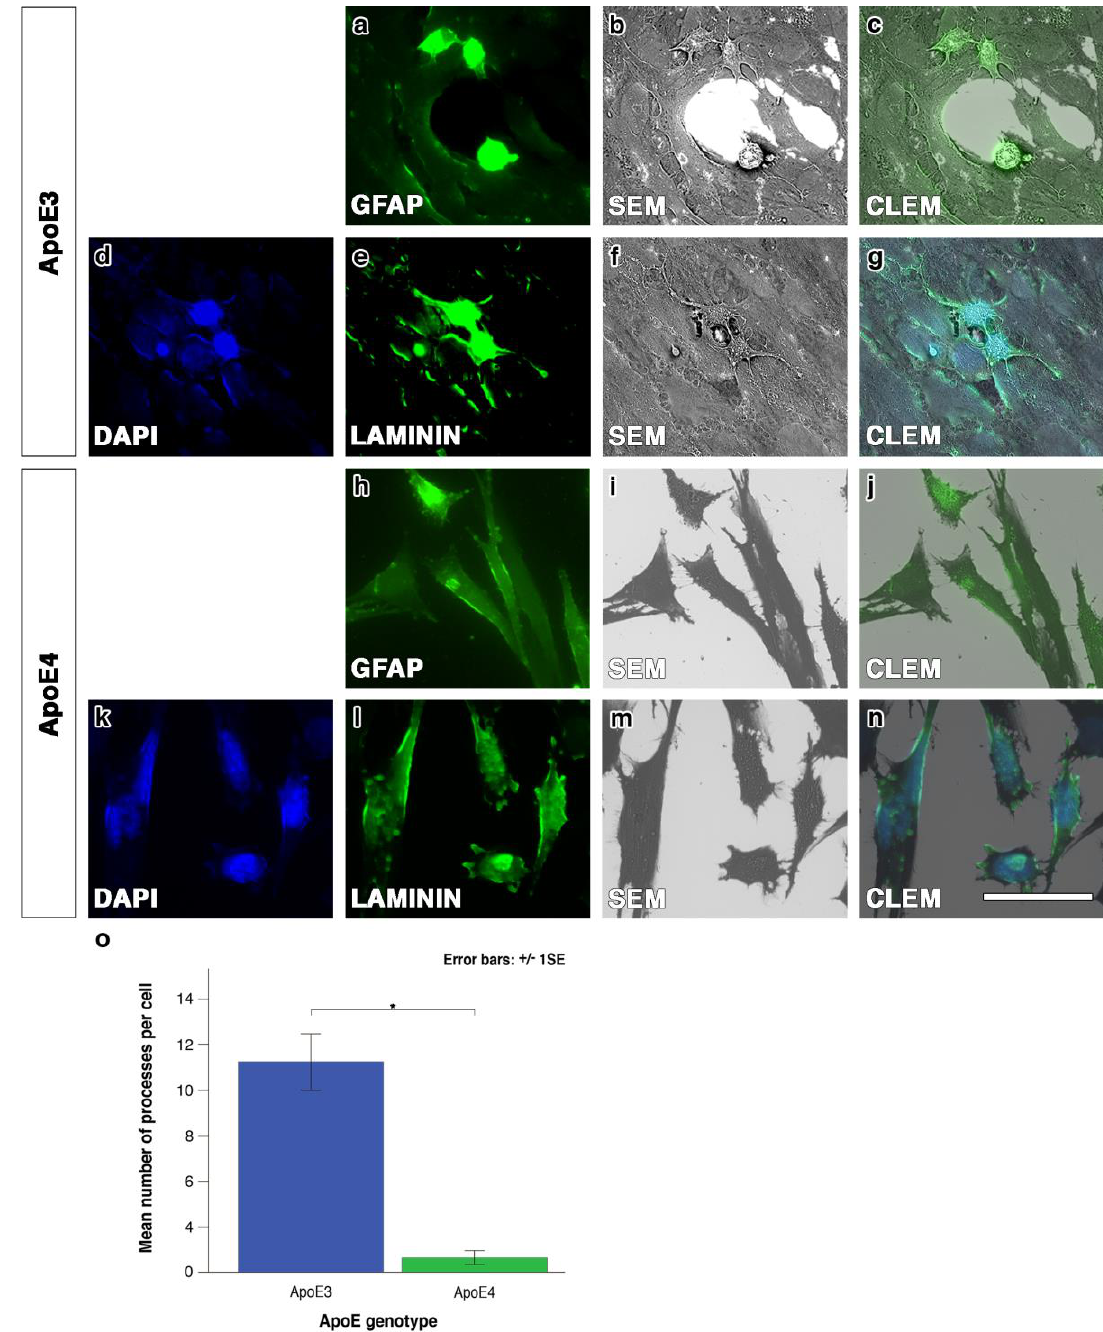
Figure 2. The appearance and quantification for ApoE3 and ApoE4 astrocytes with Correlative Light and Electron Microscopy (CLEM). Immunostaining with GFAP provided evidence the cells were astrocytes ( a , h ). Laminin immunostaining with DAPI nuclear stain ( d ) for ApoE3 astrocytes showed strong laminin immunolabelling of the cell bodies and processes ( e ) and the SEM ( b , f ) and CLEM features ( c , g ) showed a round / hexagonal / pentagonal shape of the cell body. ApoE4 astrocytes immunolabelled with laminin ( l ) and DAPI nuclear counterstain ( k ) showed very little immunolabelling of cell processes. The SEM ( i , m ) and CLEM ( j , n ) demonstrated the elongated shape of the cell bodies for ApoE4 astrocytes. ( o ) There was a significant reduction in the number of processes in ApoE4 astrocytes as compared to ApoE3 (* p < 0.001). Green: immunostaining with GFAP or laminin. Blue: DAPI counterstain. Results were based on data gathered over three independent experiments and error bars represent the standard error of the mean, scale bar: 40 µ